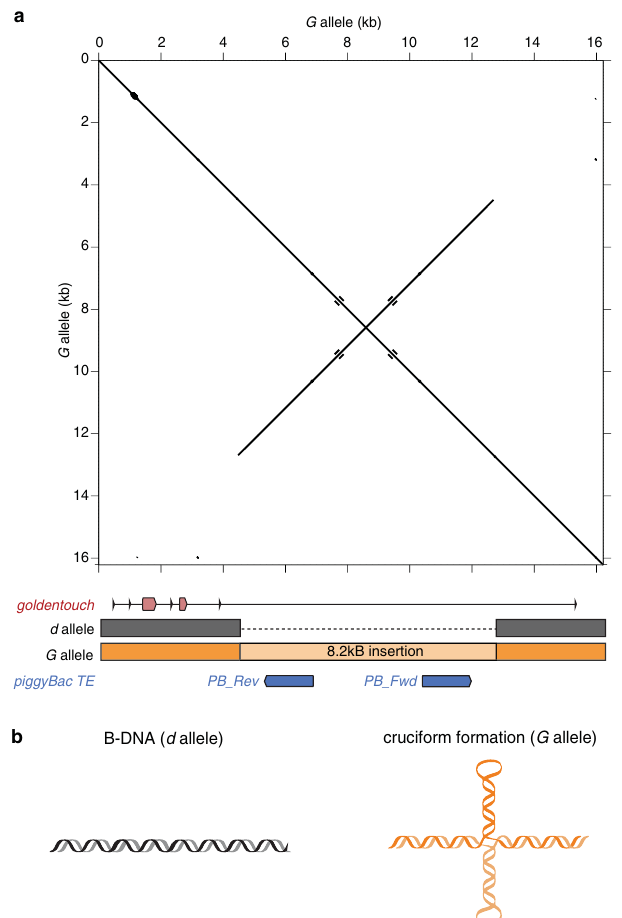
Fig. 4 Structural properties of the structural variant in gold Midas cichlids. a A dotplot of the golden allele at the genomic position of the goldentouch gene. The structural variant we identi fi ed based on a haplotype- resolved PacBio HiFi assembly of a heterozygous golden individual is an 8.2 kb transposon-derived inverted repeat with identical copies of a piggyBac transposable element (TE). b The two alleles likely differ in their secondary structure as inverted repeats are known to form cruciform structures. The part of the two copies that form the stem of the DNA cruciform have sequence similarity and differ only at two positions (two single-base-pair